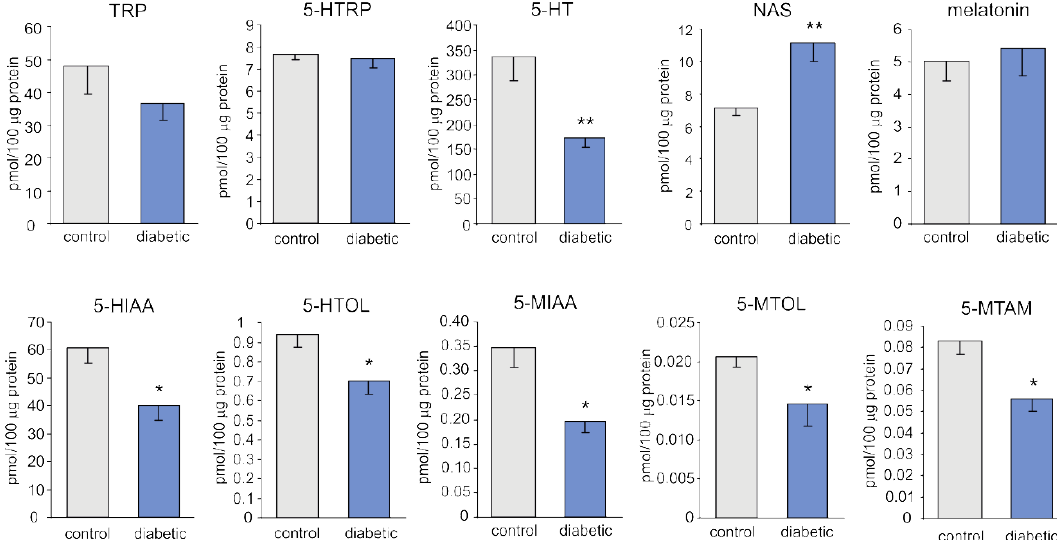
Figure 1. The content (per 100 μg of protein) of melatonin synthesis-related indoles in the pineal glands of control and diabetic pigs. The means significantly different from those of the control group are marked with asterisks; single asterisk (*) indicates p < 0.05, double asterisk (**) represents p < 0.01.